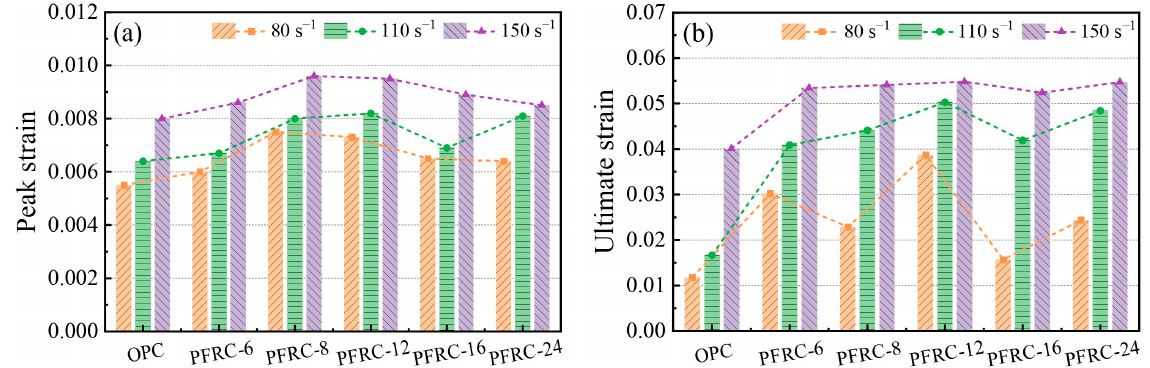
Figure 12. Dynamic compression deformation of each group of specimens at different strain rates: ( a ) dynamic peak strain and ( b ) dynamic ultimate strain.